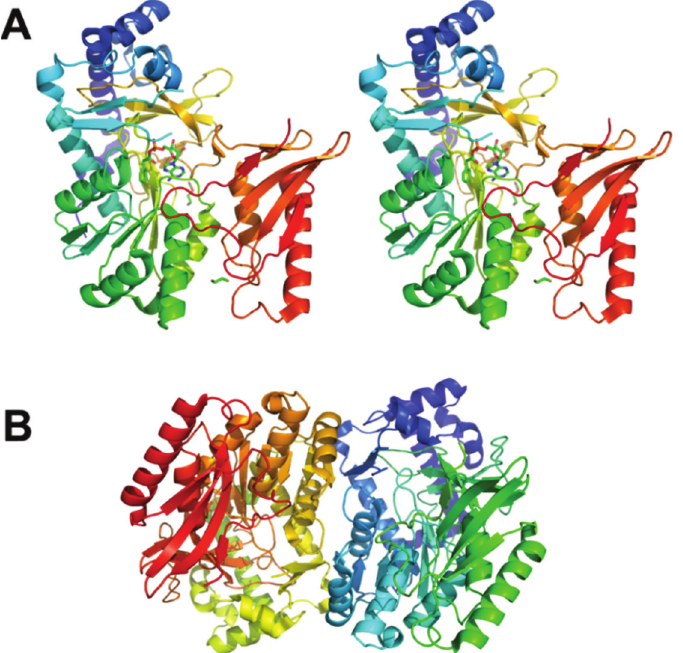
Figure 1. The crystal structure of PaaK1 from Burkholderia cenocepacia . ( A ) The stereoview of the PaaK1 monomer with the phenylacetyl adenylate intermediate painted in rainbow colors from blue at the N-terminus to red at the C-terminus. ( B ) Biological unit of PaaK is a dimer. This and other figures were prepared using PyMol